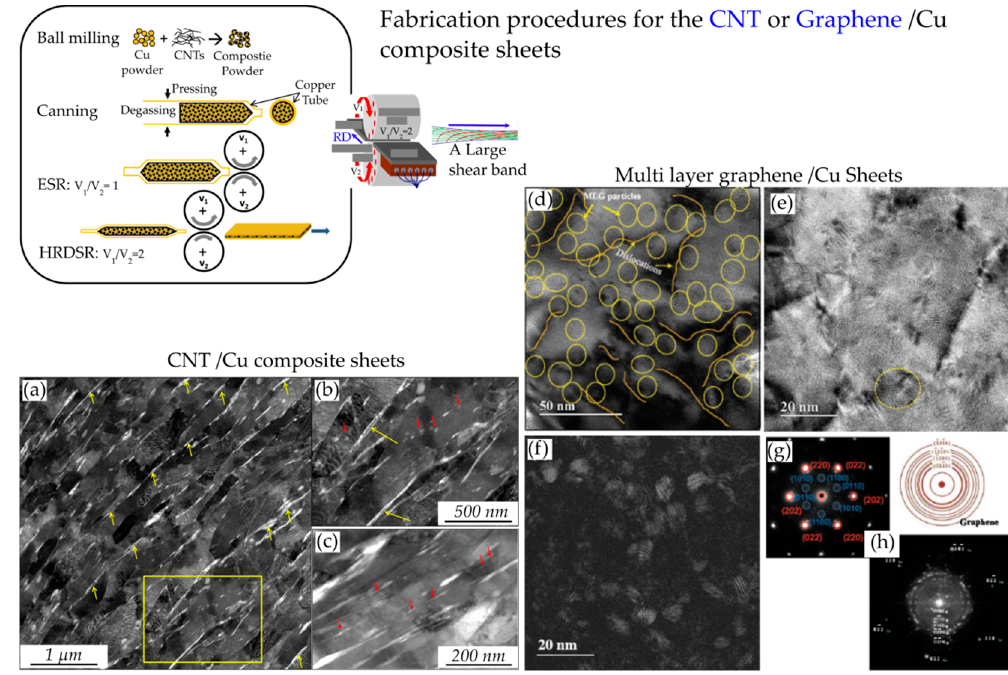
Figure 20. ( a ) A bright-field TEM micrograph of the 3% carbon nanotube- (CNT)-HRDSR Cu composite [74]. ( b ) High magnification TEM image of the box area in (a). ( c ) CNT in the grain interiors of the composite. ( d , e ) High-resolution TEM micrographs of the 1% multilayer graphene (MLG)-